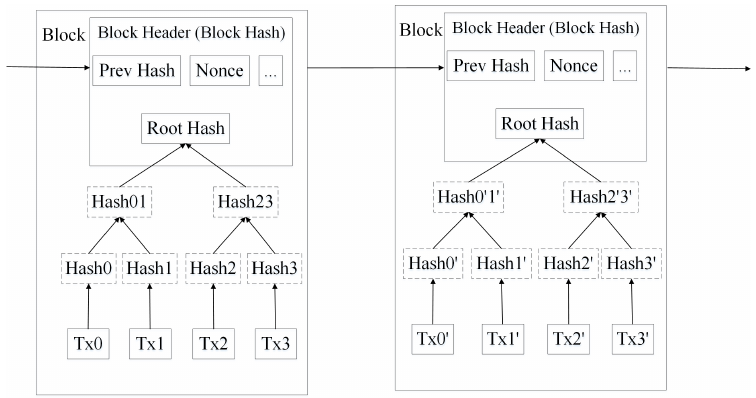
Figure 1. Blockchain